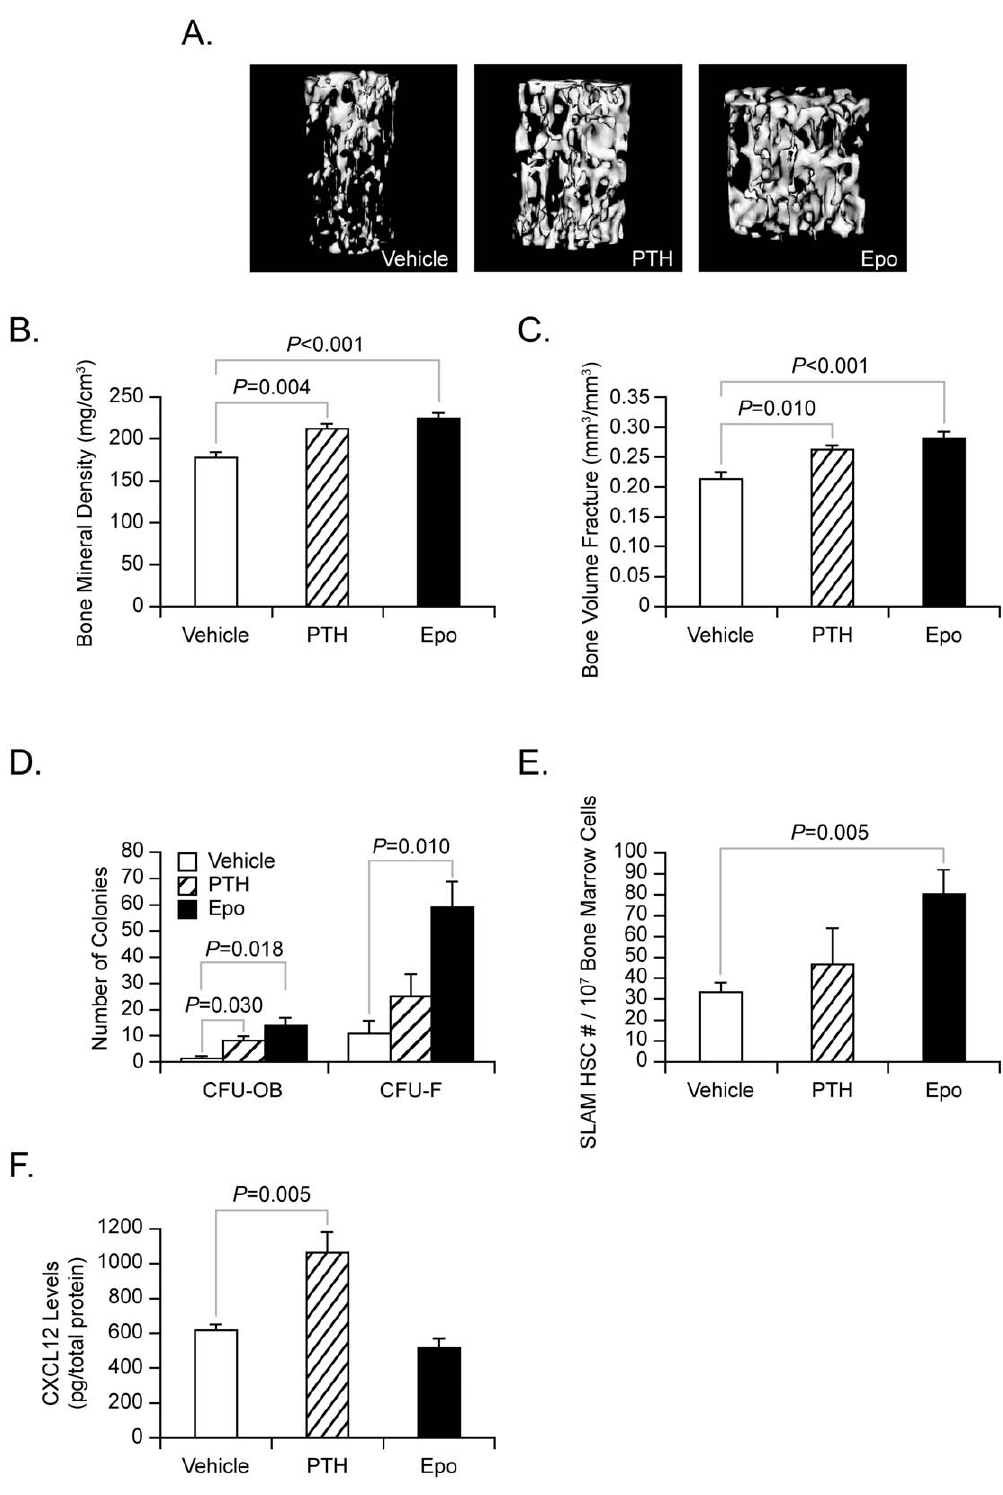
Figure 5. Epo induces bone formation invivo in mature animals. To determine if Epo is able to stimulate bone formation in mature animals, 4-6-week-old mice were injected with vehicle or increasing concentrations of Epo (6000 U/kg, 3 times/week) for 28 days i.p. As a positive control for bone formation, PTH was administered using an anabolic regime (50 m g/kg s.c. , daily). n=5 per group. ( A ) The vertebral spines were fixed and 3- dimensional micro-computed tomography measurements of the vertebral spines were performed. Bone parameters including ( B ) BMD and ( C ) BVF were calculated. ( D ) Mixed marrow mononuclear cells derived from the treated-animals were cultured in mineralizing conditions (ascorbic acid & b - glycerol phosphate). At 21 days, the cultures were examined for CFU-OB (Alizarin Red stainig) or CFU-F (Crystal Violet staining) colonies. ( E ) The numbers of SLAM HSCs were counted by FACS. ( F ) The levels of CXCL12 in the marrow were measured by ELISA. Data are presented as the mean 6 standard error of the mean. Significant differences from vehicle treatment groups.